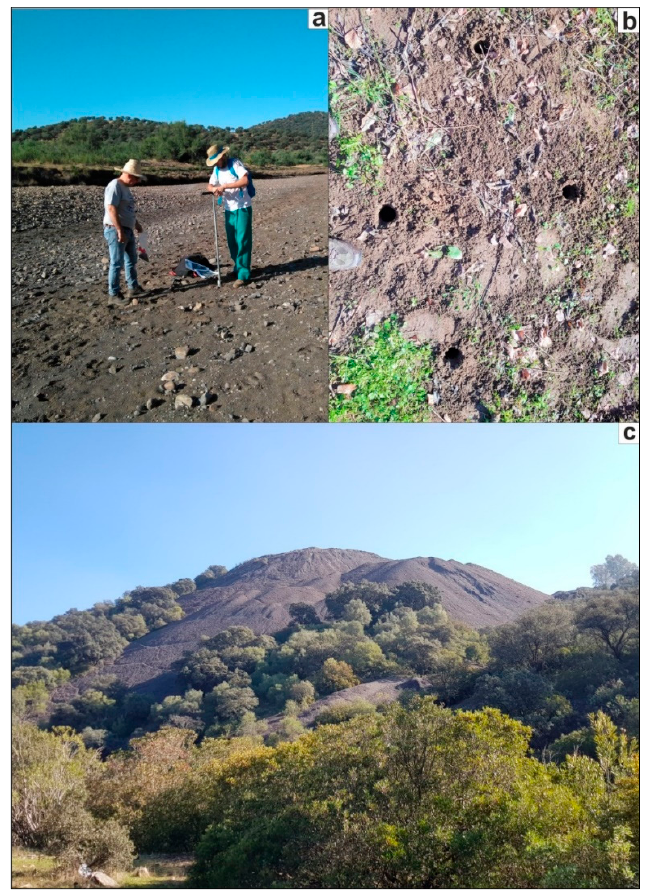
Figure 2. ( a ) Sediment sampling with Edelman auger in the floodplain of the Grande River, at the tail-end of the reservoir. ( b ) Four sub-samples arranged in a cross with a spacing of 1 m were collected at each sampling point. ( c ) Mining wastes deposited near the banks of the Renegadero River.